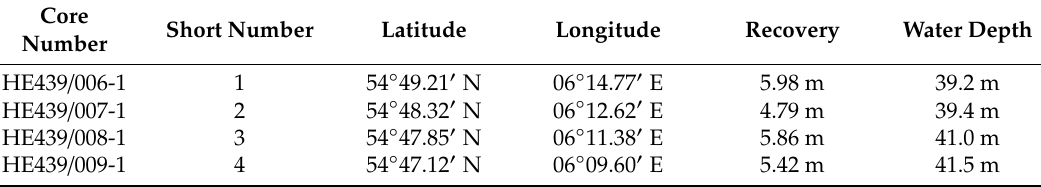
Table 2. Details of core sampling sites. The short number is the number used within the text and figures. Core